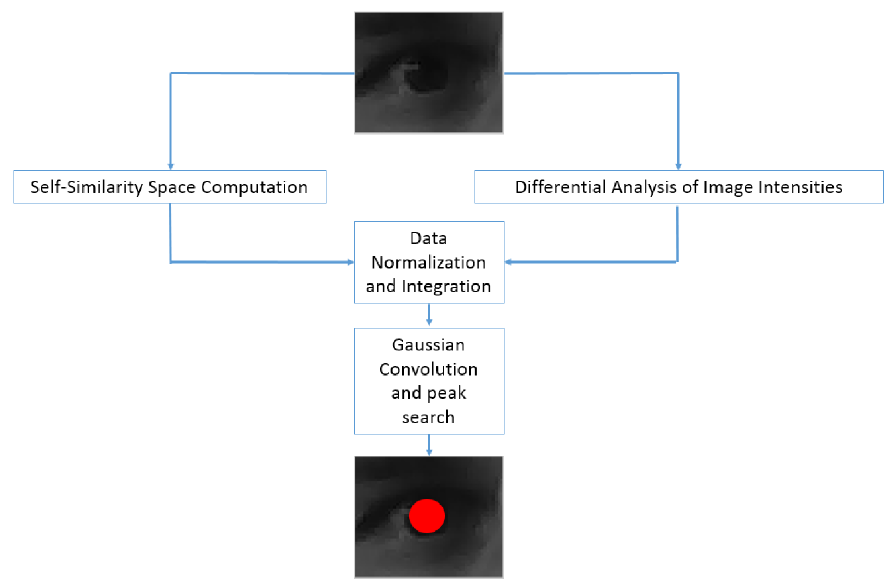
Figure 5. Scheme of the pupil detection